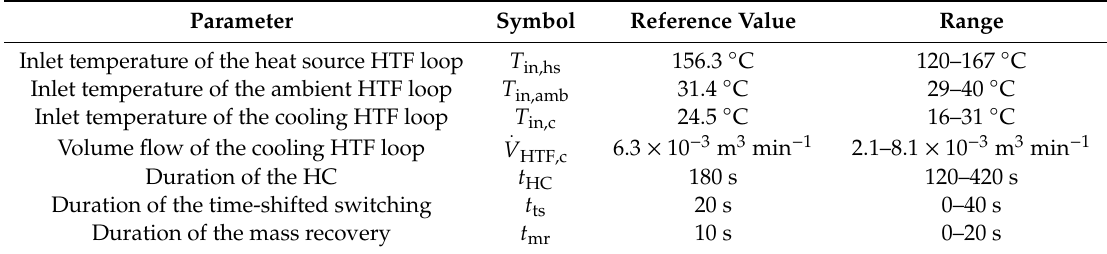
Table 3. Overview of varied operating